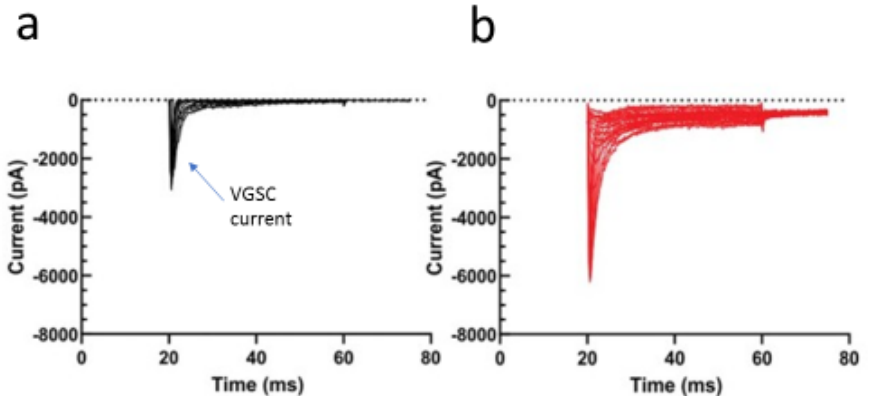
Figure 2. Enhancement of peak and late currents produced by endogenous voltage-gated sodium channels in rat DRG neurons by paclitaxel (PTX). Endogenous Nav1.7 currents were elicited by 40ms depolarizing voltage steps from − 80mV to +10mV in 5mV increments from a holding potential of − 100mV. ( a ) Control data from neurons treated with DMSO. ( b ) Data from neurons treated with 25 nM PTX. Modified from Akin et al. [45].